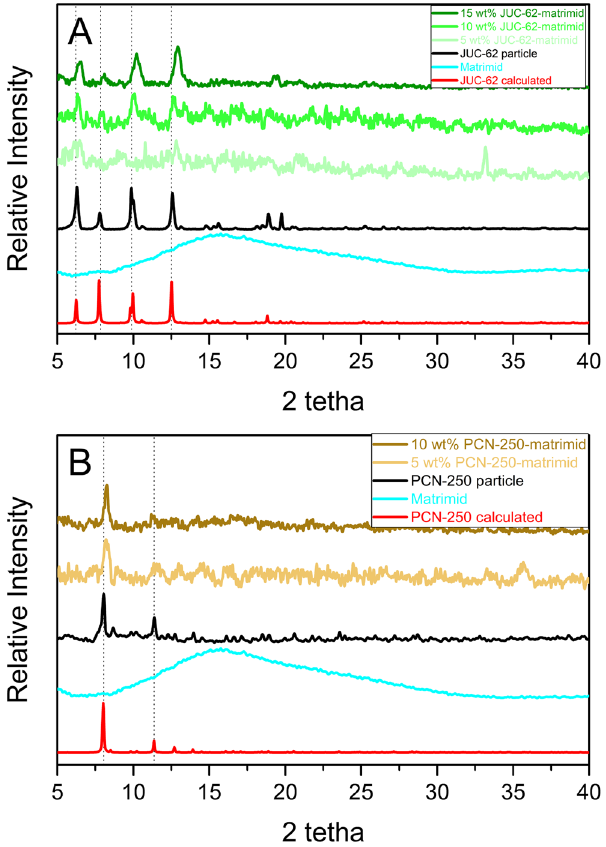
Figure 1. PXRD Spectrum of JUC-62 ( A ) and PCN-250 ( B ) matrimid mixed matrix